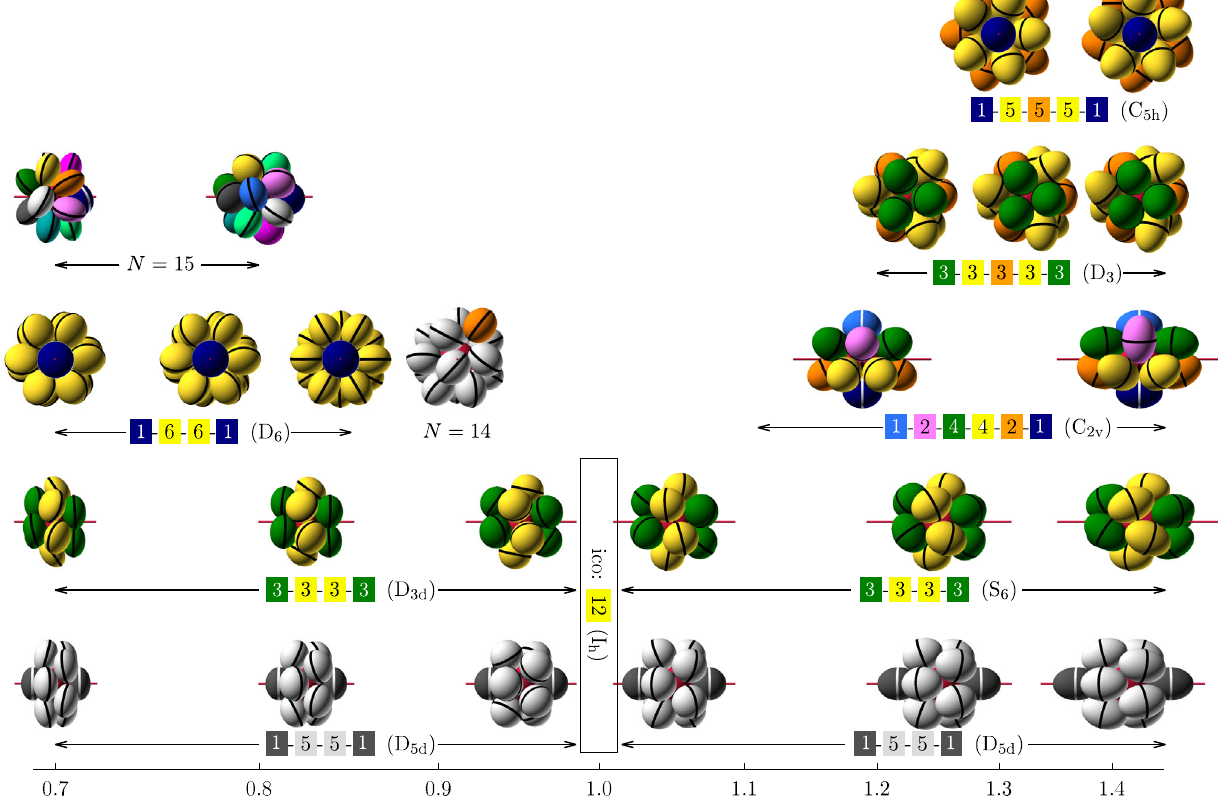
FIG. 4. Evolution of the densest structural motifs with aspect ratio α . In addition to the number of particles in each ring (color-coded boxes), we give the point group for each structure. The oblate structures marked N ¼ 15 and N ¼ 14 have no nontrivial symmetries. The 1-5-5-1 structures (gray) never exceed the